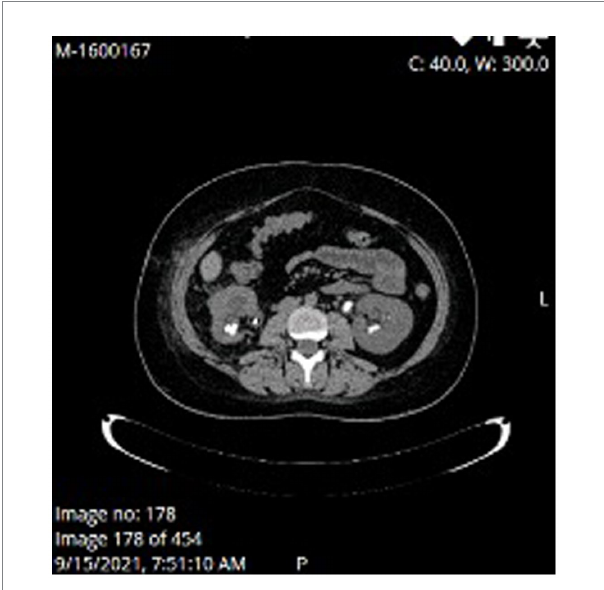
FIGURE 2 MSCT at the time of acute kidney